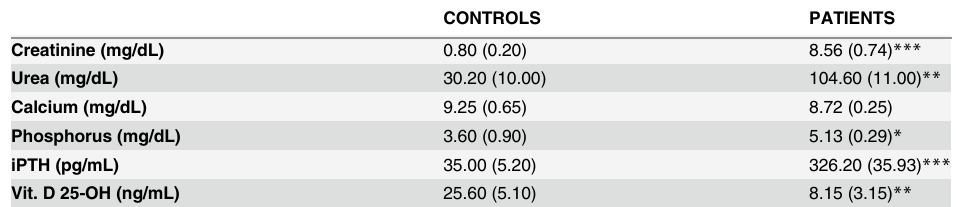
Table 1. Biochemical parameters of controls ’ and patients ’ serum CONTROLS